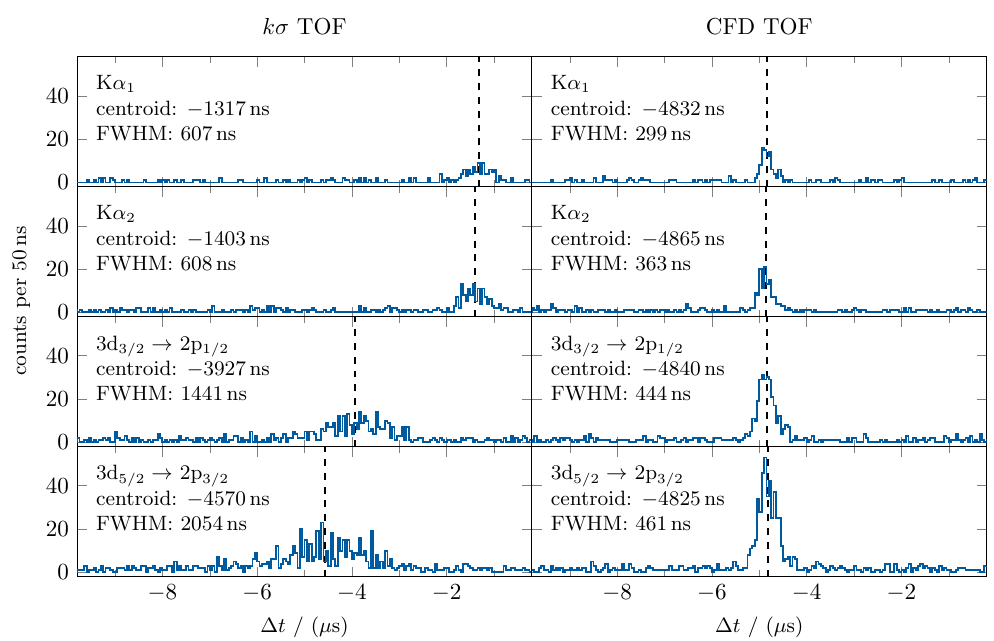
Figure 2. Time-of-flight (TOF) spectra of photons emitted from U 90 + (in four distinct regions of interest) relative to the arrival time of the corresponding down-charged ions. Data recorded by the 180 ◦ microcalorimeter and the particle detector. The data resulted from the application of the k σ (left) and the CFD trigger (right). Noteworthy differences are the broader range of arrival times of the k σ trigger, i.e., worse timing resolution, than that of the CFD trigger, as well as a pulse-amplitude- dependent shift in the mean arrival time recorded by the k σ trigger. See text for details.